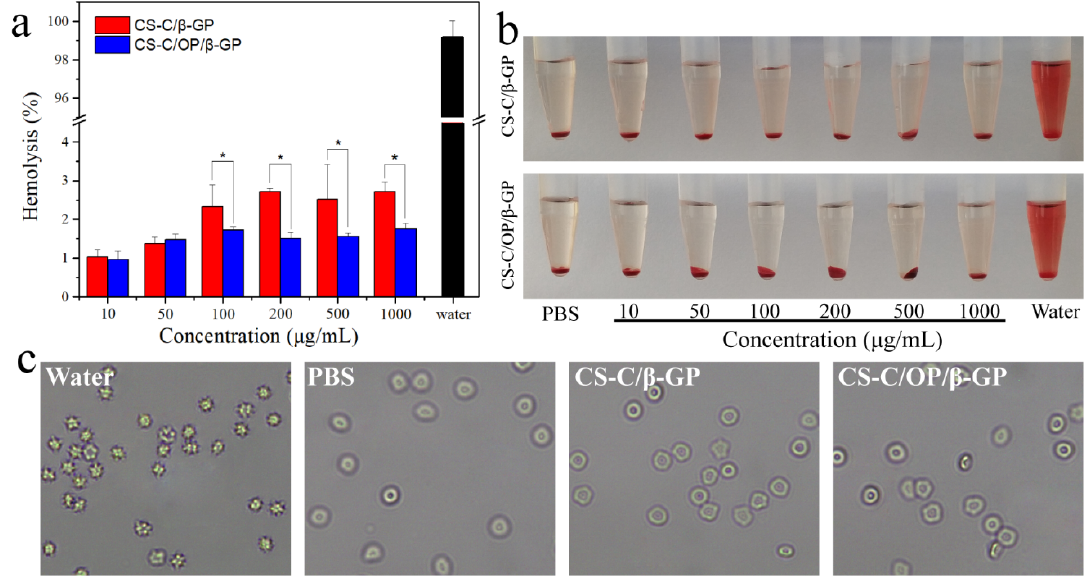
Figure 10. ( a ) Hemolysis ratio, ( b ) RBC suspension solutions, and ( c ) microscopy of RBCs treated with samples, * p < 0.05.